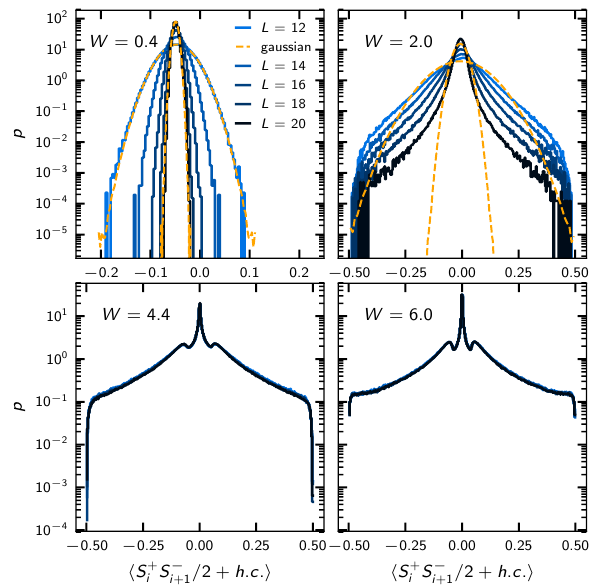
Figure 2: Finite size dependence of the probability density of eigenstate expectation | n 〉 . As in Fig. 1, the histogram values of the nearest neighbor flip operator 〈 n | F i , i + 1 is taken over (cid:166) 50 eigenstates per disorder realization, > 1500 disorder realizations and all positions i in the chain. The dashed blue line shows the gaussian distribution computed with the mean and variance belonging to the data L =